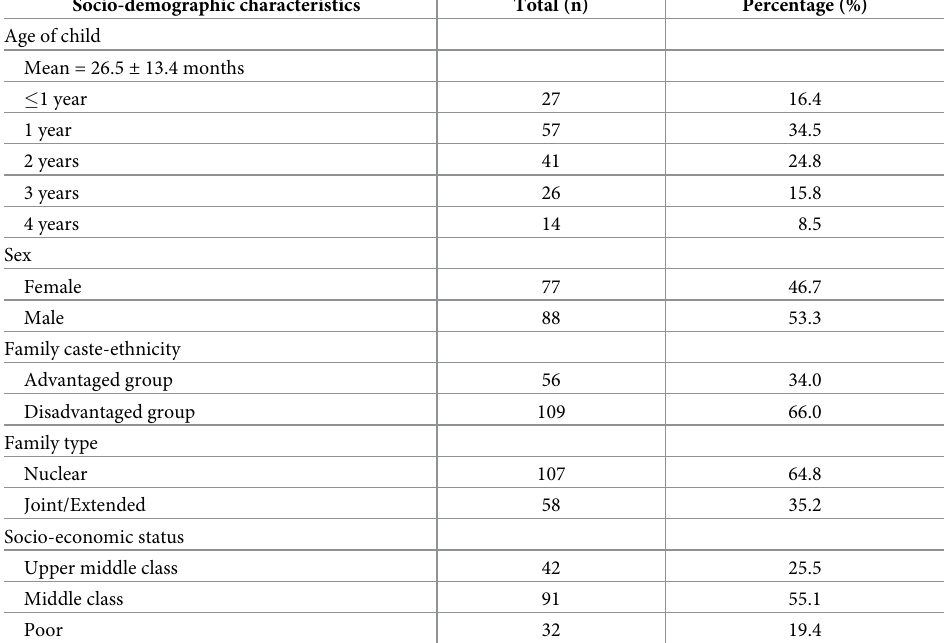
Table 1. Socio-demographic